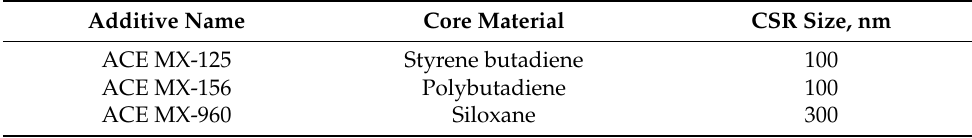
Table 1. CSR types dispersed in the epoxy